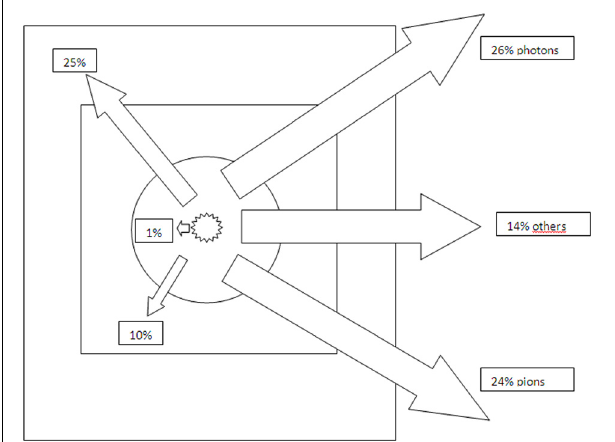
FIGURE 1 | Energy deposition (particle rest mass and kinetic energy of the antiproton) in relation to particle type and location relative to the annihilation point (in percent) [13]. The circle denotes the region within 5mm of the annihilation point, the inner rectangle the planning target volume (10 × 10 × 10cm 3 ) and the outer rectangle the water phantom (50 × 50 × 150cm 3 ). With increasing distance from the point of annihilation, the contribution towards energy deposition of protons, pions and electrons increases, whilst the proportion of heavy particles